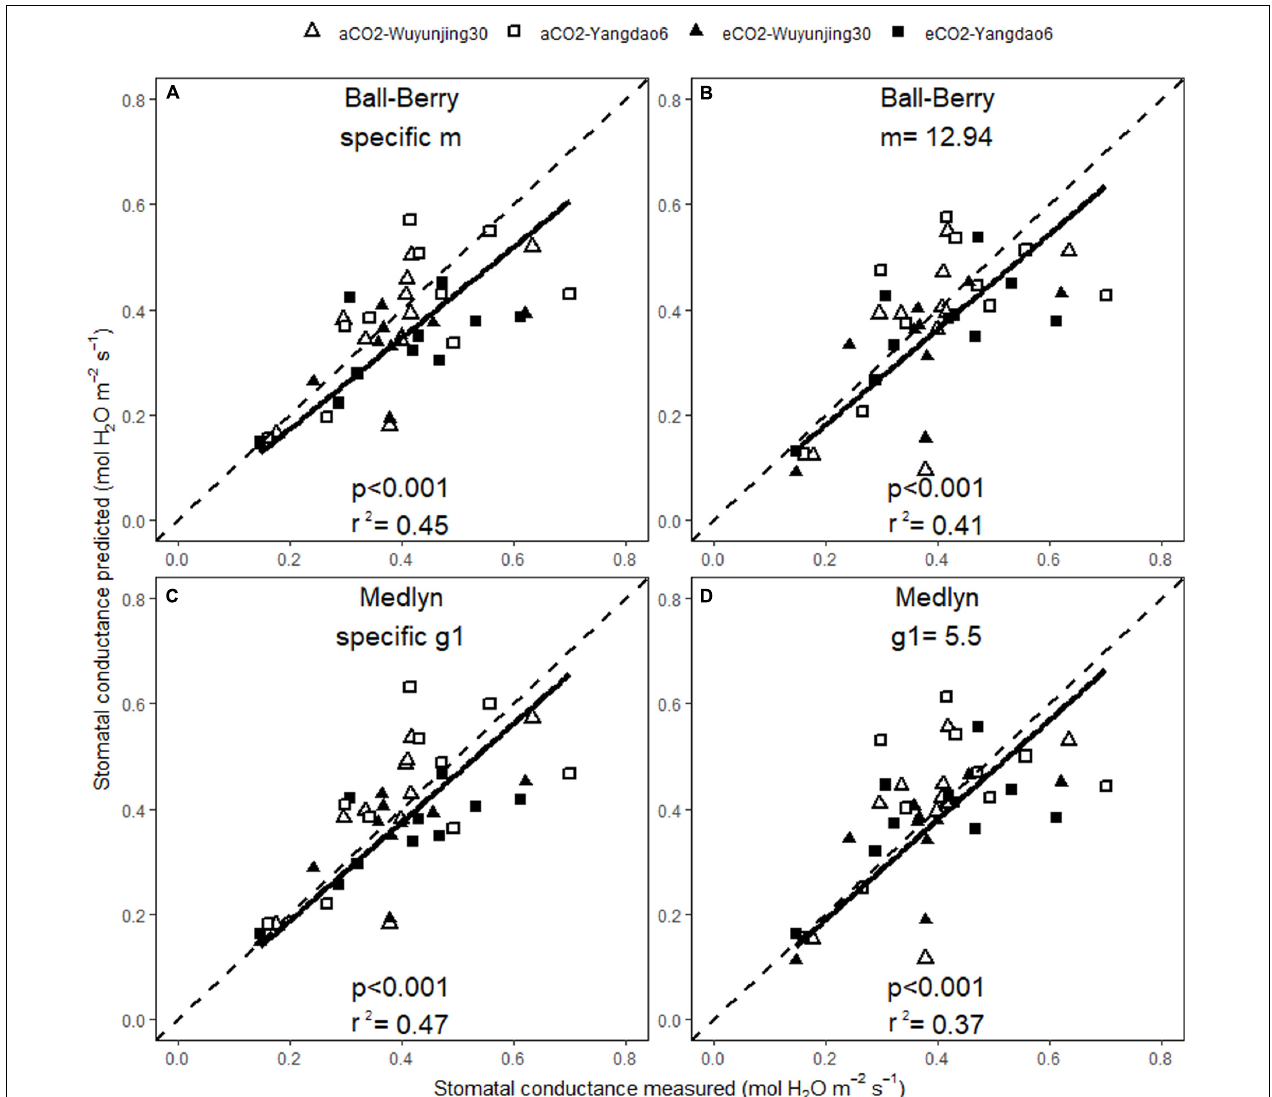
FIGURE 6 | Relationships between the measured and simulated daily average stomatal conductance for the two rice cultivars at ambient and elevated (CO 2 ) throughout the growing season. Stomatal conductance was simulated with BWB (A,B) or MED models (C,D) , using either specific model parameters (A,C) or generic model parameters (B,D) . p value of the correlation analysis and the square of Pearson correlation coefficient (r 2 ) are